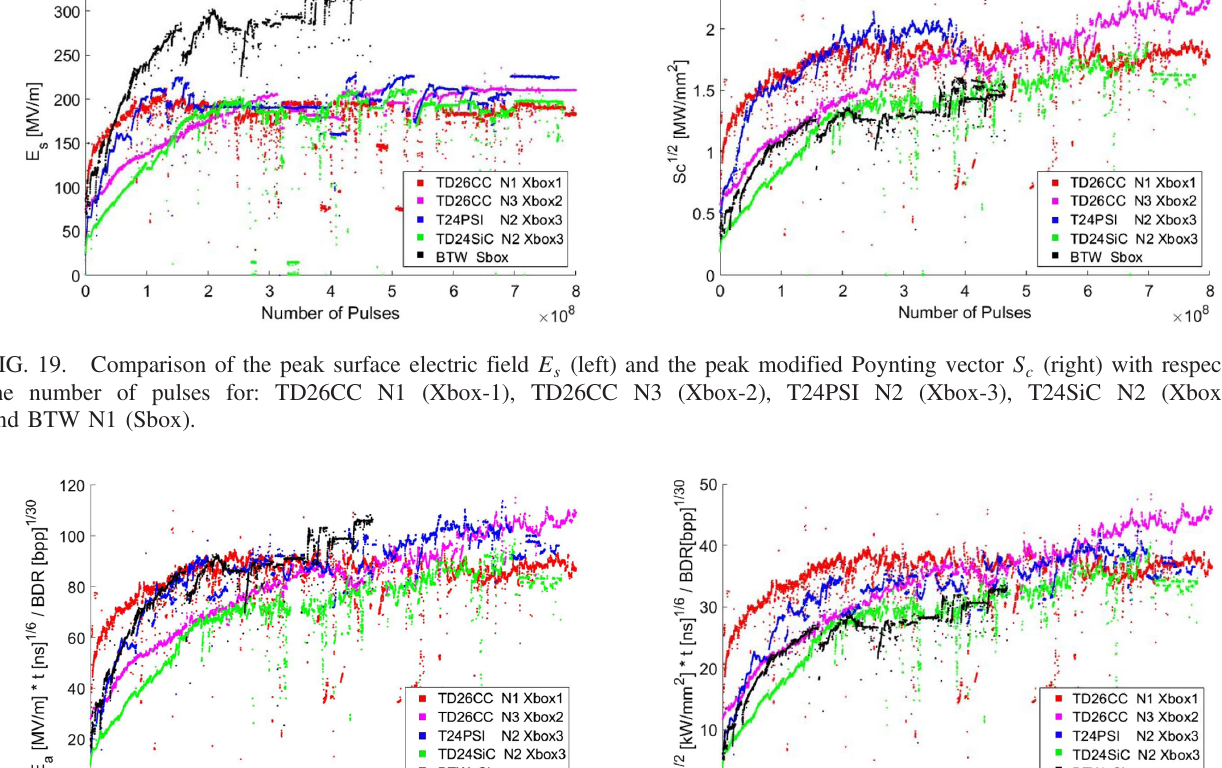
Fig. 20 the processing history of the X-band the BTW S- band structures look similar. However according to the result shown in Fig. 9, the power law scaling measured for the BTW structure is E 10 . Using this parameter, the scaled a